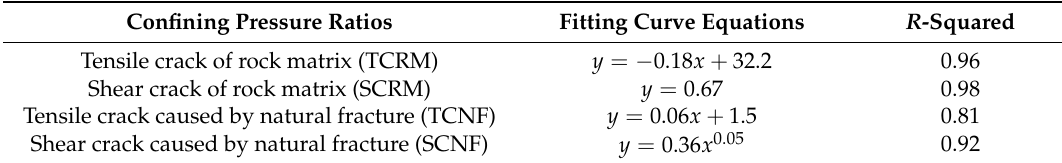
Figure 19. Variation of tensile crack of rock matrix (TCRM), shear crack of rock matrix (SCRM), tensile crack of natural fracture (TCNF), and shear crack of rock matrix (SCNF) in various NF densities. Table 4. Fitting curve equations of the number of cracks for different NF densities.